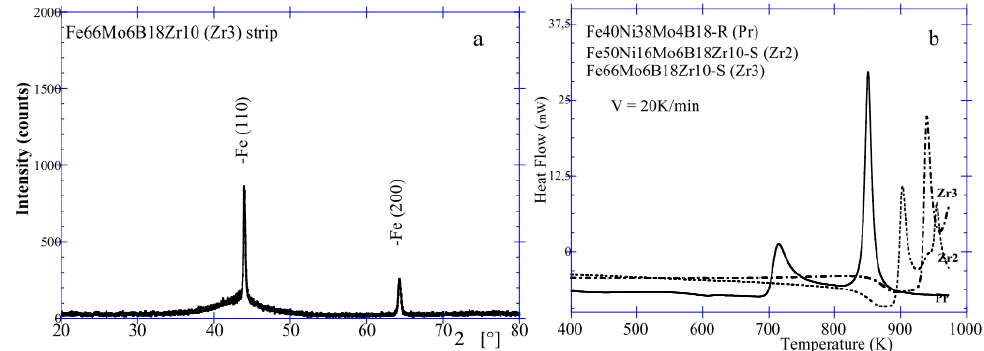
Mo B Zr 66 6 18 10 and ε ; ( d ) Sketch showing the 1 2